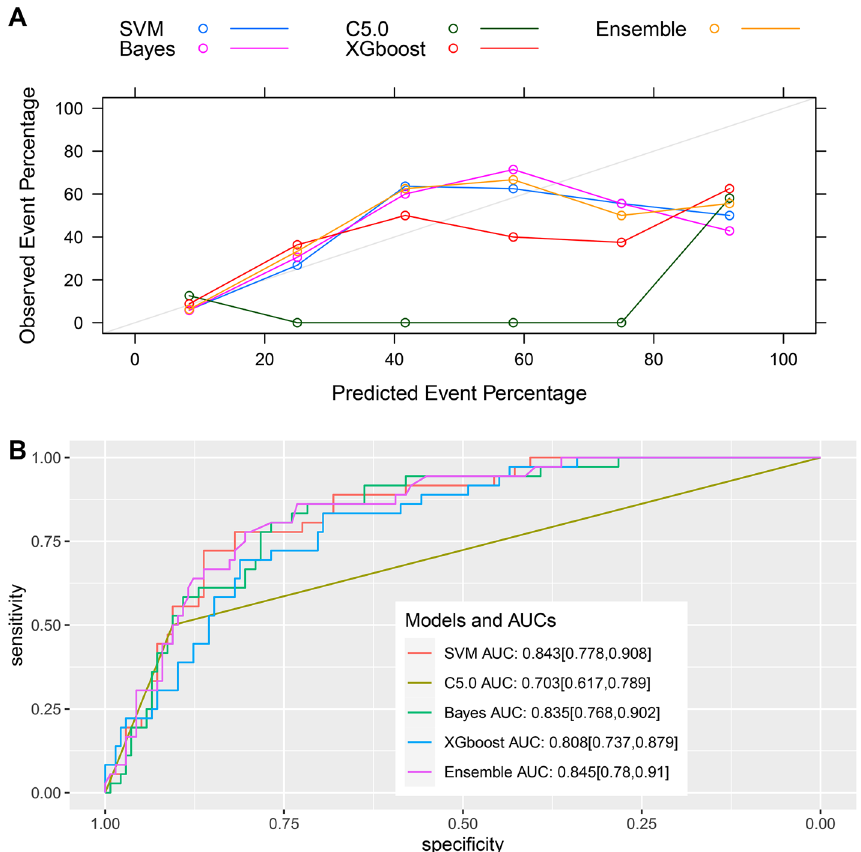
Figure 3. Evaluation of model performance in the internal validation dataset. ( A ) The calibration plot shows the consistency between observed and predicted risks for persistent acute kidney injury. ( B ) Discrimination of the machine learning models in the internal validation dataset. SVM, support vector machine; XGBoost, extreme gradient boosting; AUC, area under the curve. The number in parentheses indicates the 95% confidence interval.